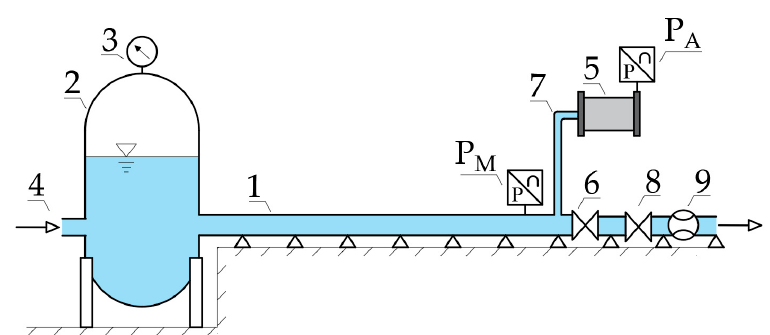
Figure 2. Experimental setup: 1—main pipeline, 2—pressure tank, 3—Bourdon pressure gauge, 4— water supply system, 5—additional pipe, 6—valve initiating transient flow, 7—connecting pipe, 8— 8—regulating valve, 9—inductive flow meter, P M —pressure sensor installed in main pipeline P A